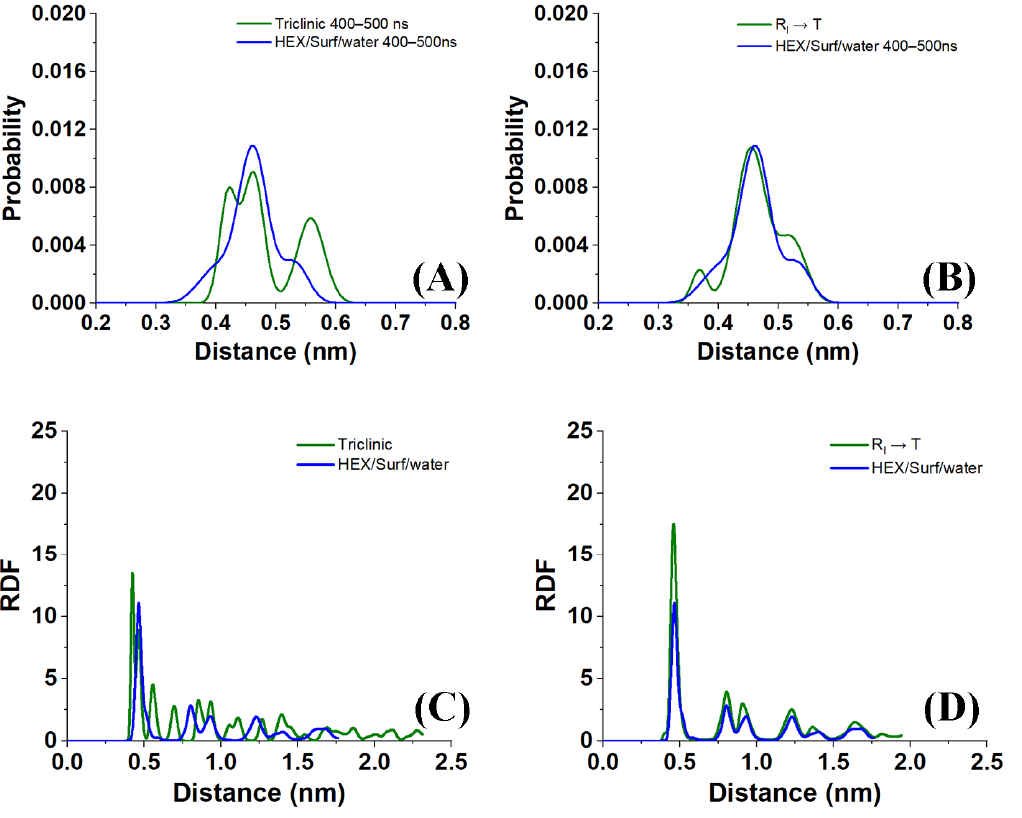
Figure 8. ( A , B ) Distances between the nearest neighbors and ( C , D ) RDF profiles in crystallite 1 of the HEX/Surf/water system simulated at 289 K compared with reference systems [19] of bulk HEX in ( A , C ) triclinic phase and ( B , D ) rotator phase. All data in the graphs were obtained by averaging over the last 100 ns of a 500 ns MD production run.